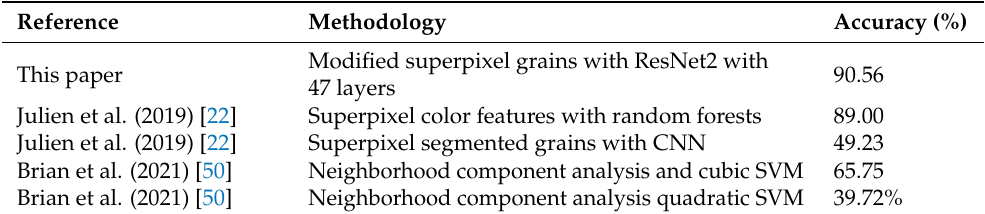
Table 5. Comparison of the proposed method with existing methods.